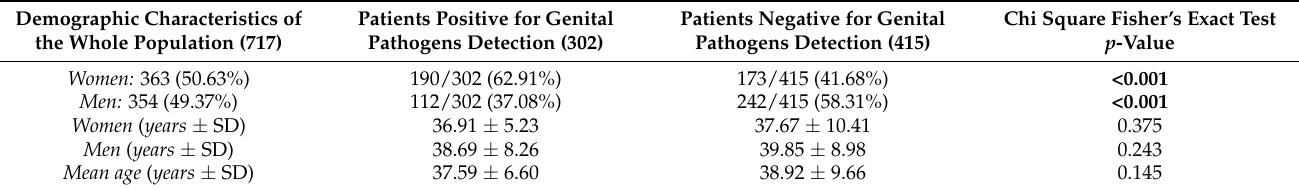
Table 1. Demographic characteristics of the subjects enrolled during the study